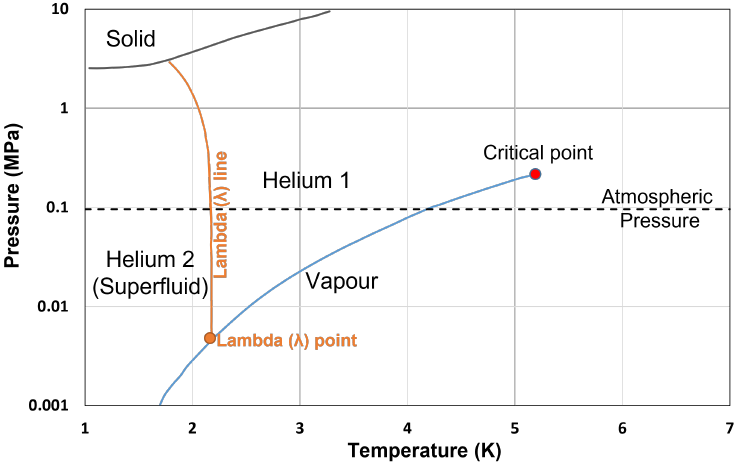
Figure 8. Phase diagram of helium with pressure in log scale. Adapted from